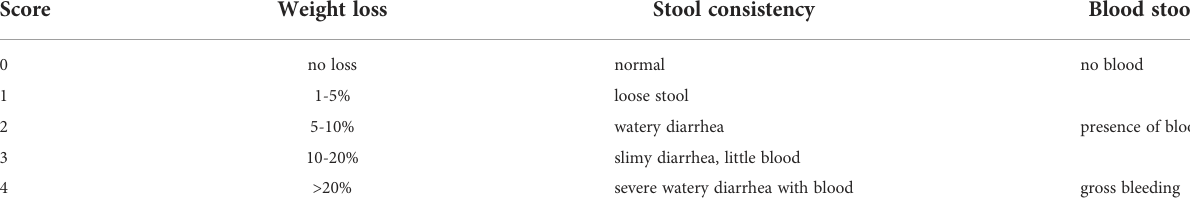
TABLE 1 Scoring system for Disease Activity Index